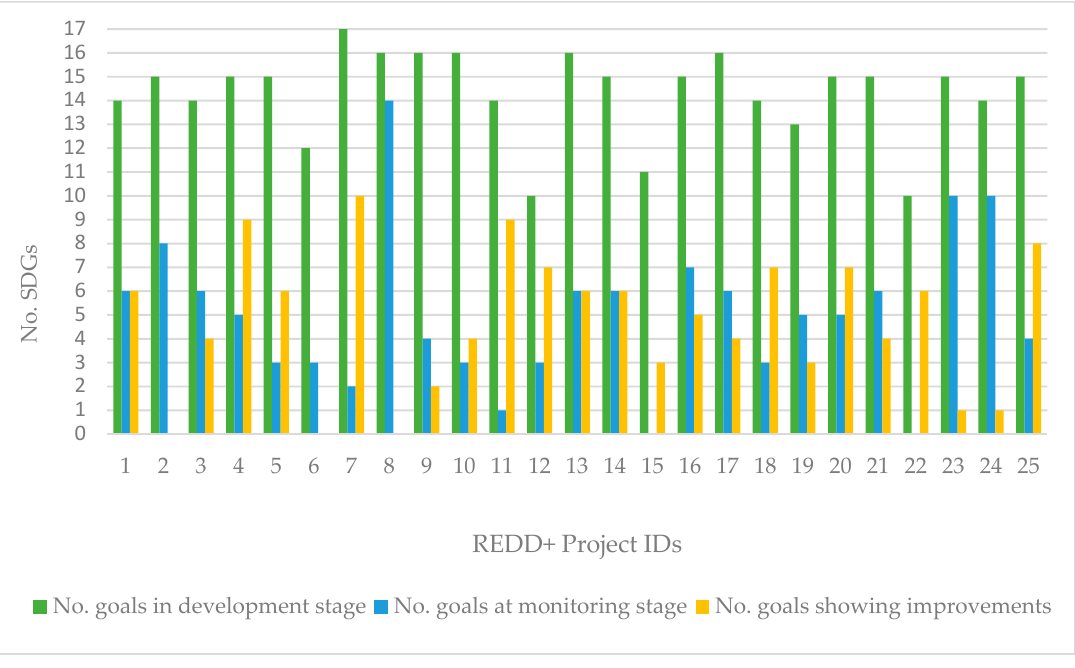
Figure A1. The number of Sustainable Development Goals addressed in the project design documents of 25 REDD+ projects, compared to the number of SDGs that are monitored (=impact score 2) and improved (= impact score 3), based on the project implementation reports.